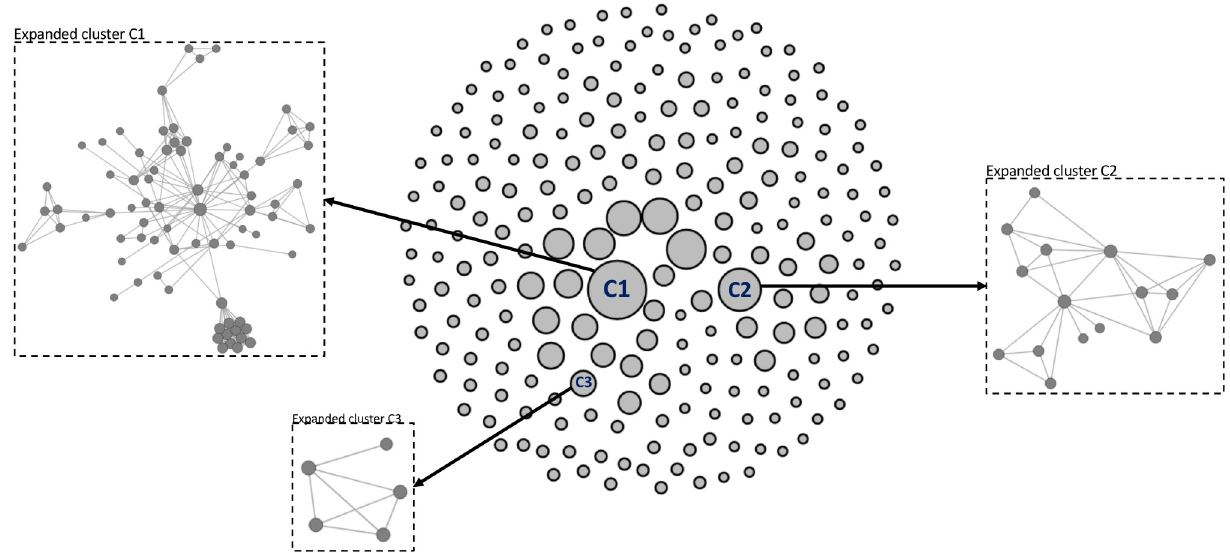
Fig 1. Sample molecular transmission network. Clusters [shown as gray circles with black borderline such as C1, C2 and C3], and three clusters are expanded for more clarity, the nodes represent viral sequences and the edges between every pair of nodes show epidemiological relatedness.